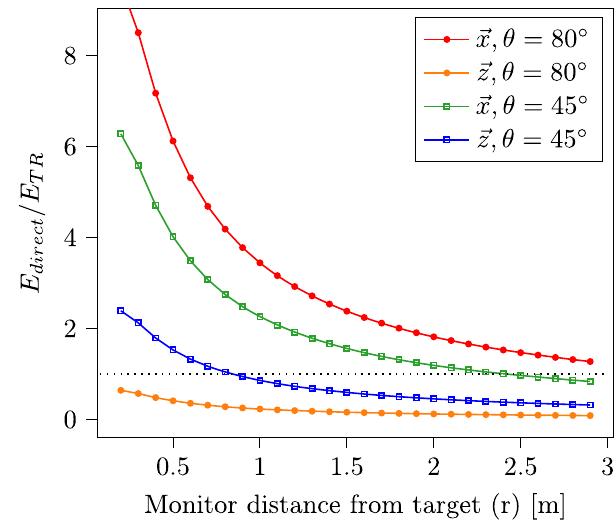
FIG. 20. Ratio of direct field against transition radiation field as a function of monitor distance from target for two monitor